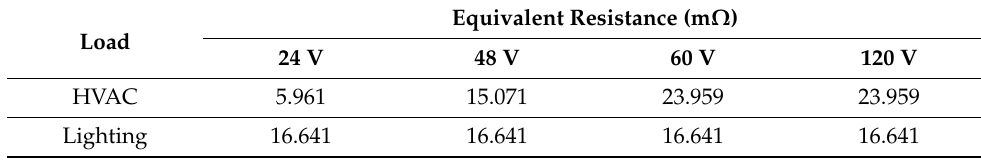
Table 1. Equivalent resistance of each category of loads for different voltage